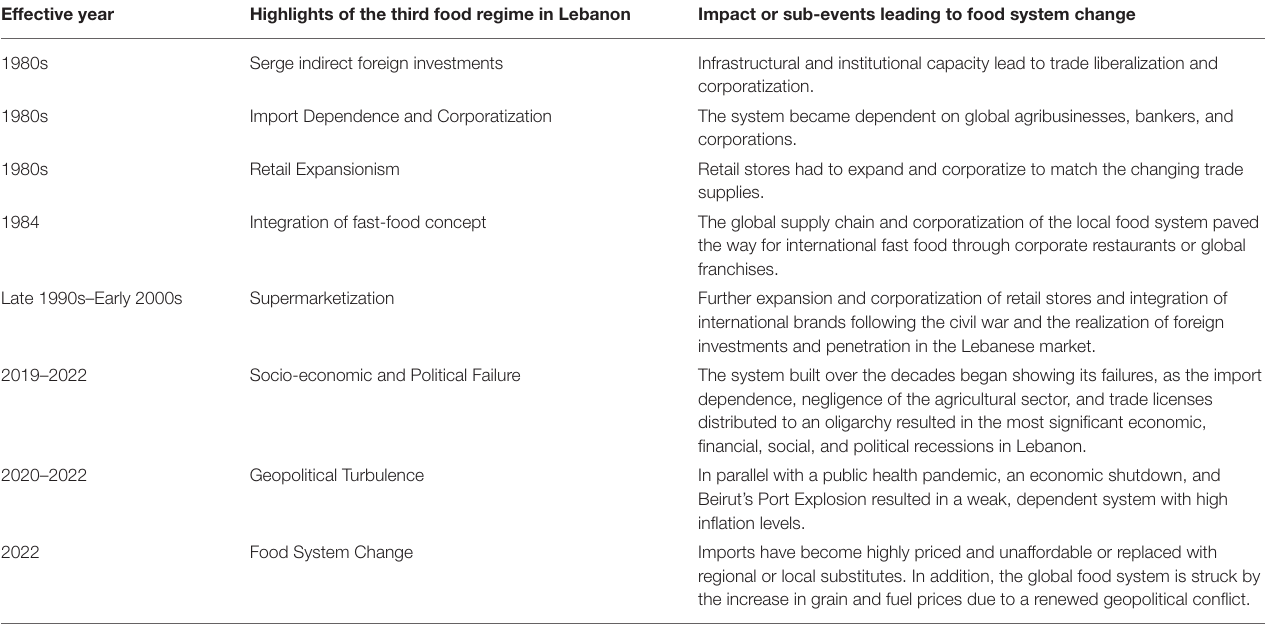
TABLE 3 | Overview of the corporate food regime in